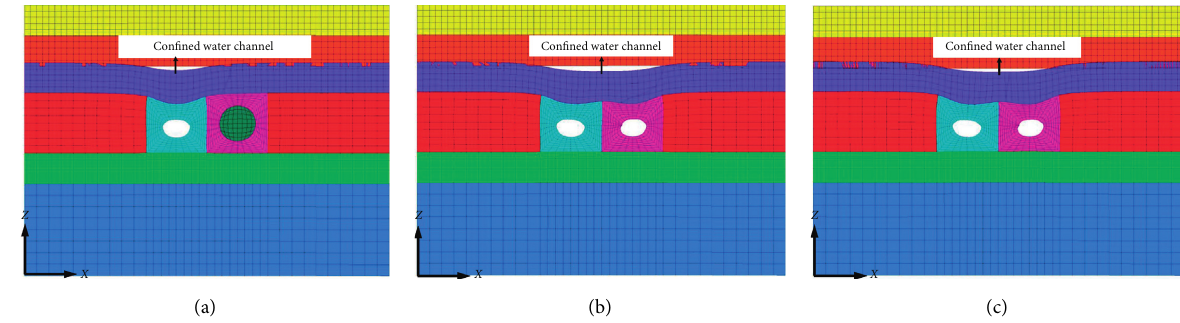
Figure 7: : Schematic diagram of channel formation. (a) Left side excavation; (b) right side excavation; (c) simultaneous excavation. Z -displacement